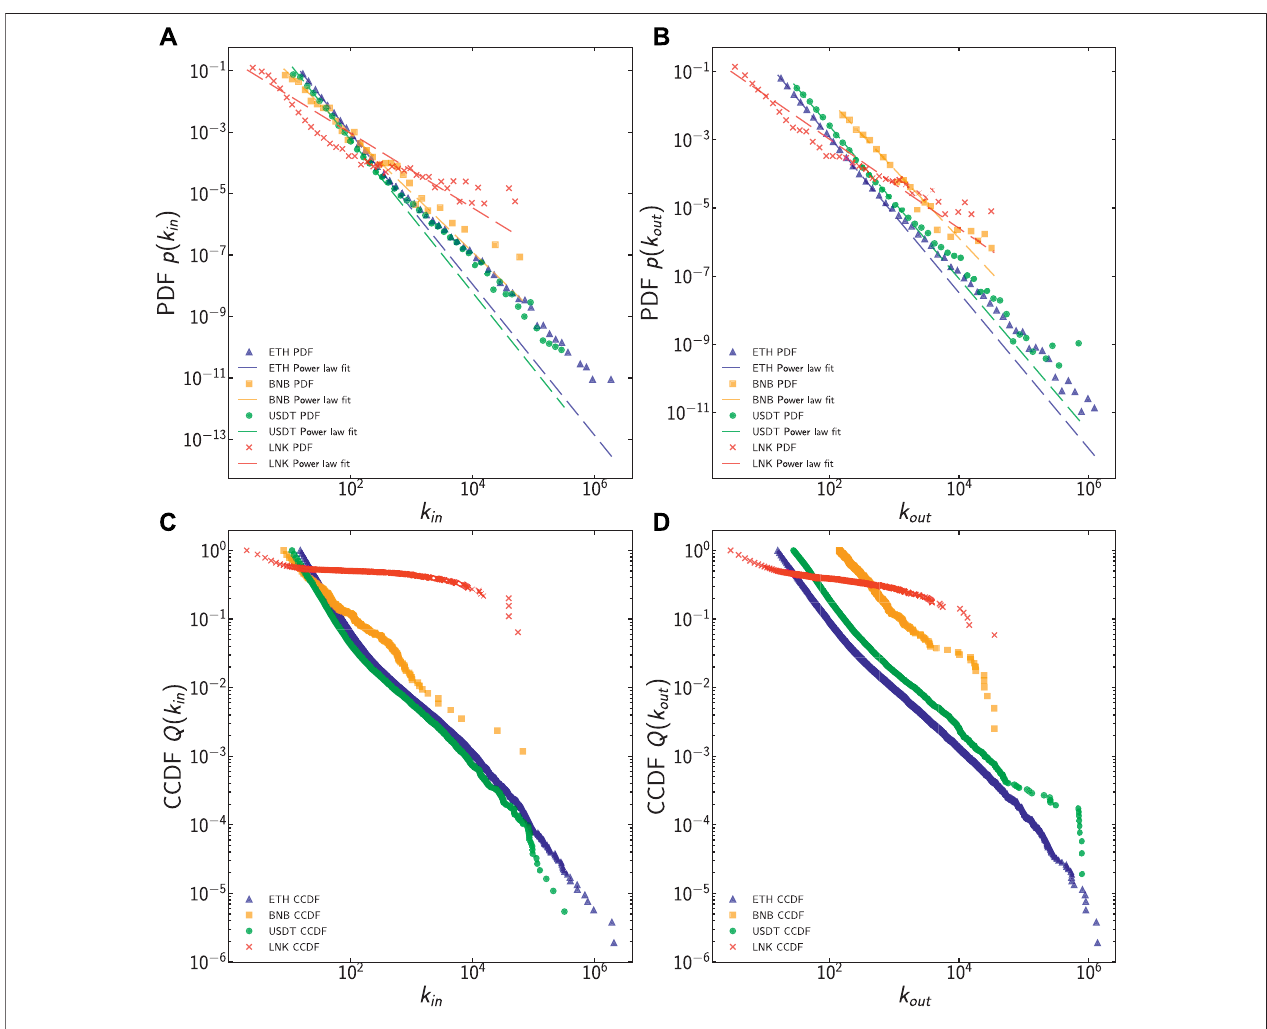
FIGURE 4 | PDF and CCDF for in-degree and out-degree in ETH, BNB, USDT, and LNK at the end of the observation period.